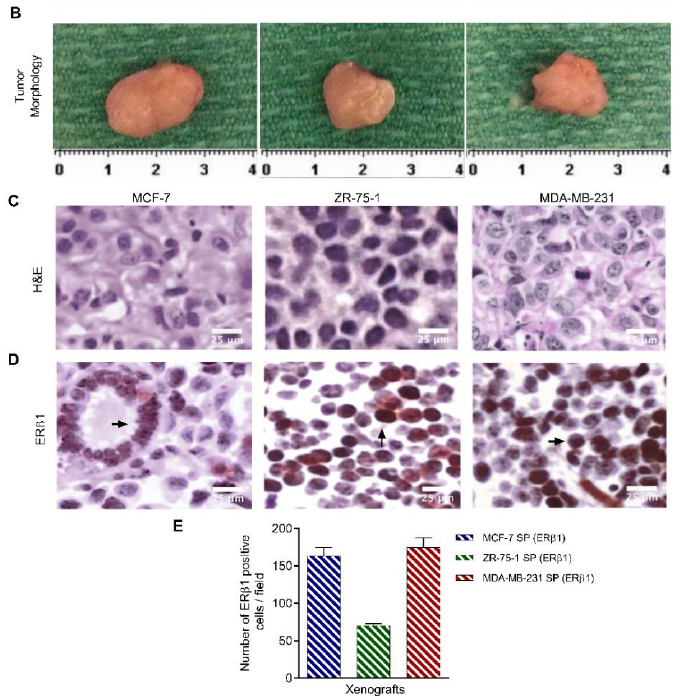
Figure 8. 3rd generation spheroids from MCF-7, ZR-75-1, and MDA-MB-231 cells co-cultured with fetal lung fibroblast cells implanted in the fourth inguinal mammary fat pad result in tumor formation. 3rd generation spheroids admixed with FLF cells for 24 h were inoculated as 5 × 10 6 viable cells mixed with Matrigel. Cells were injected into the fourth mammary fat pad of nude rates ( n = 6). Rats in the control group ( n = 9) received injections of 2D monolayer cells co-cultured with FLF mixed with Matrigel. ( A ) MRI of tumor mass. Tumors are detected as a hyperintense signal on T2-weighted images. ( B ) Tumors were excised before they reached the permitted endpoint (1.5 cm in diameter). ( C ) H&E histology of resected tumors fixed in 10% neutral buffered formalin at room temperature and embedded in paraffin, sectioned into 5 μm thick slices. ( D ) Paraffin sections of resected tumor tissues were stained with primary antibodies against the estrogen receptor β1 (ERβ1) (1:200). Immunoperoxidase labeling was performed using the ABC Peroxidase Standard Staining Kit. Images of stained tumor tissue were taken using a light microscope. ( E ) Data from immunoperoxidase labeling assay. Bar graph representative of the number of positive ER β 1 cells per field ± SEM, was quantified for xenografts grafted from SP for all three cell lines ± SEM, n = 5. Abbreviations: PA, parental; SP, spheroid; ER β 1, estrogen receptor β 1; 2D,